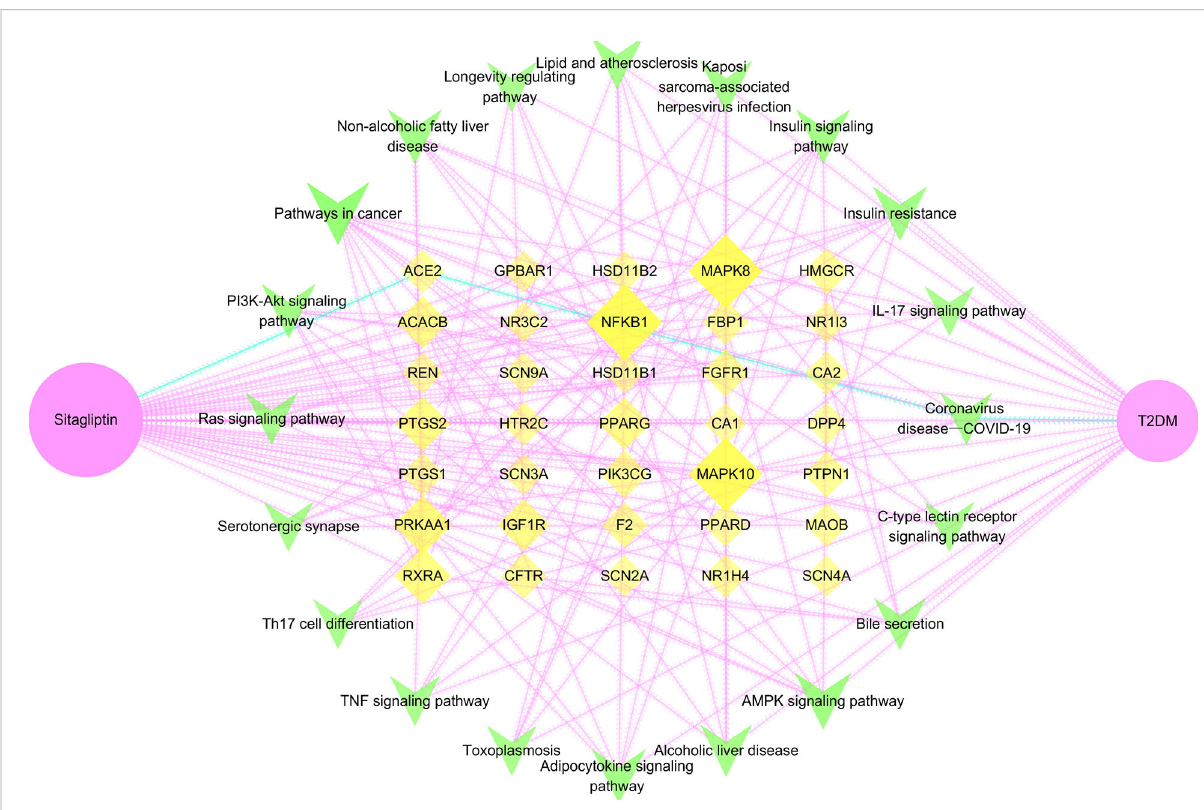
FIGURE 7 Drug ― target ― signaling pathway ― disease network. Pink node is sitagliptin, yellow node is target, green node is signaling pathway, blue edge is the pathway of sitagliptin targeting ACE2 for T2DM; larger and darker areas indicate more important